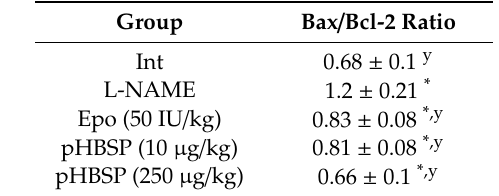
Table 1. The ratio between the Bax and Bcl-2 expression (M ± SD, n =